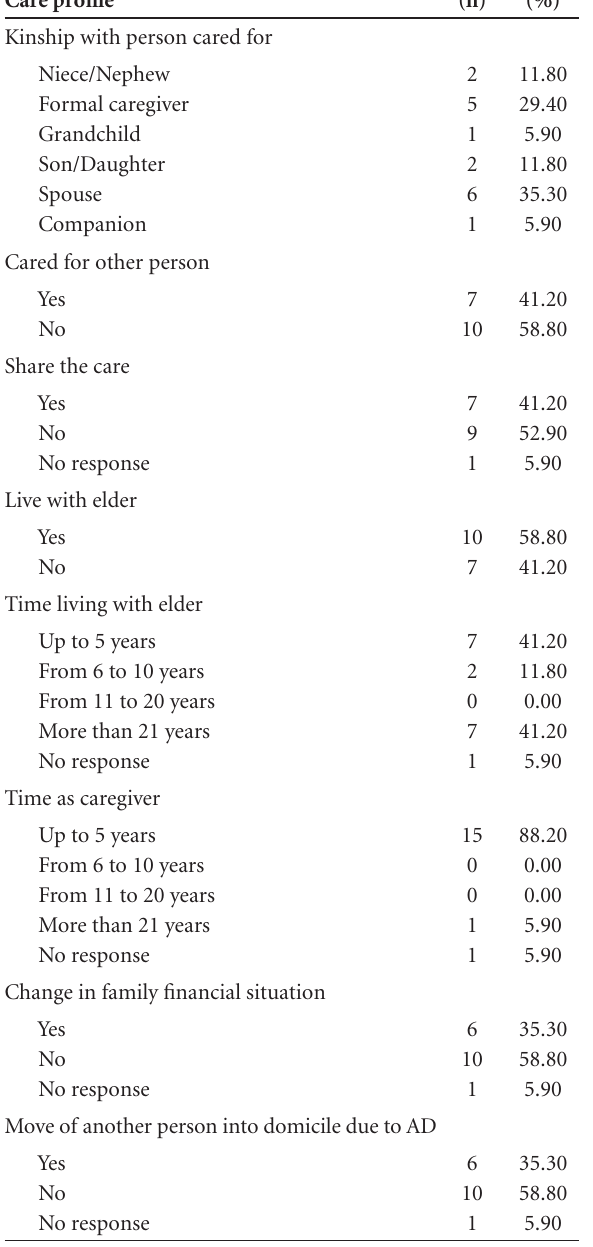
Table 1. Care profile among caregivers and elderly with Alzheimer’s